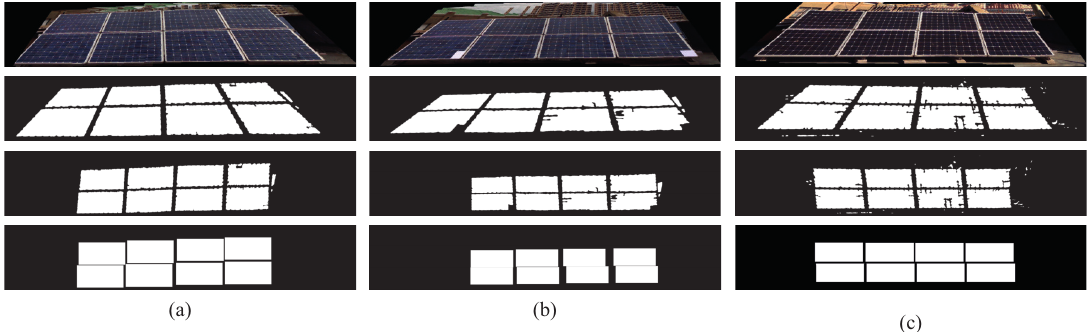
Figure 6. Results of PV-module detection algorithm applied to: ( a ) January 14th, 08:00, d = 3 m; ( b ) January 15th, 18:00, d = 4 m; ( c ) January 16th, 12:00, d = 4